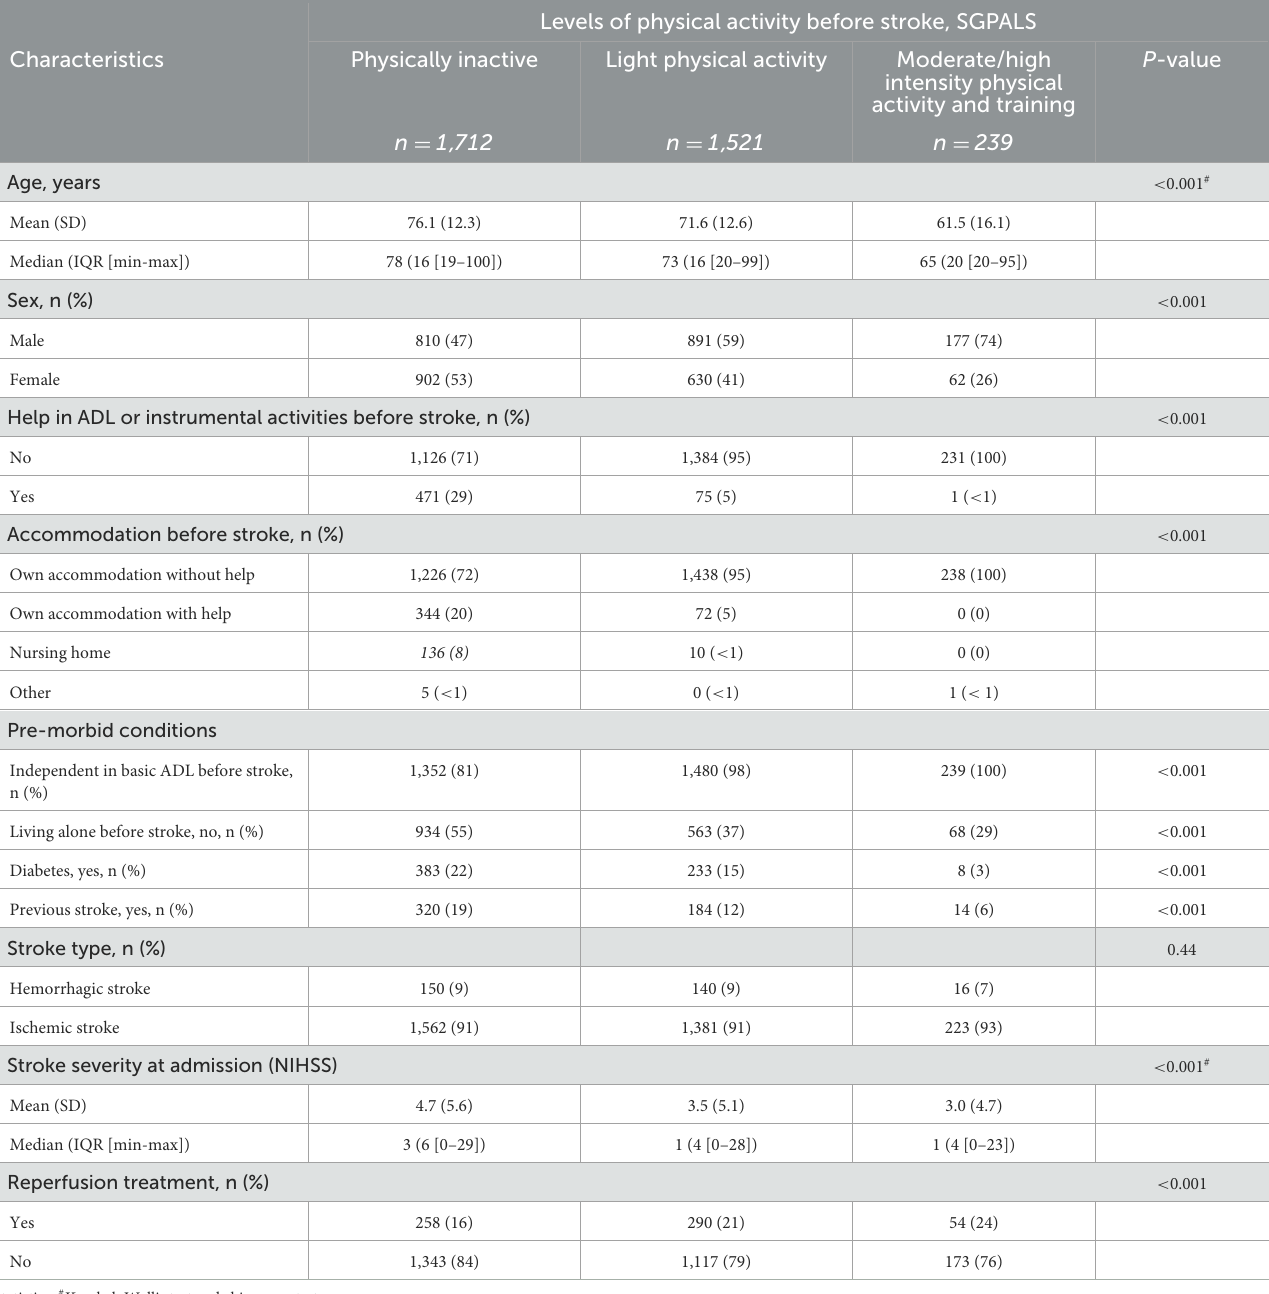
TABLE 1 Characteristics of the study sample stratified based on the levels of physical activity before